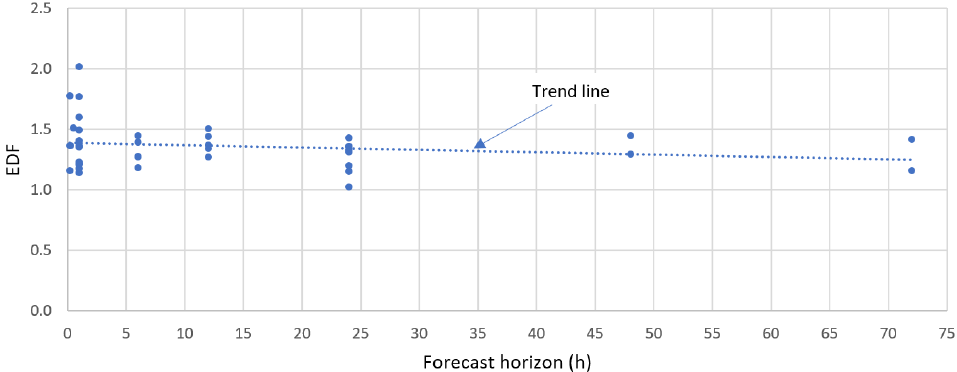
Figure 13. Dependence of nMAE errors on forecasting horizon.